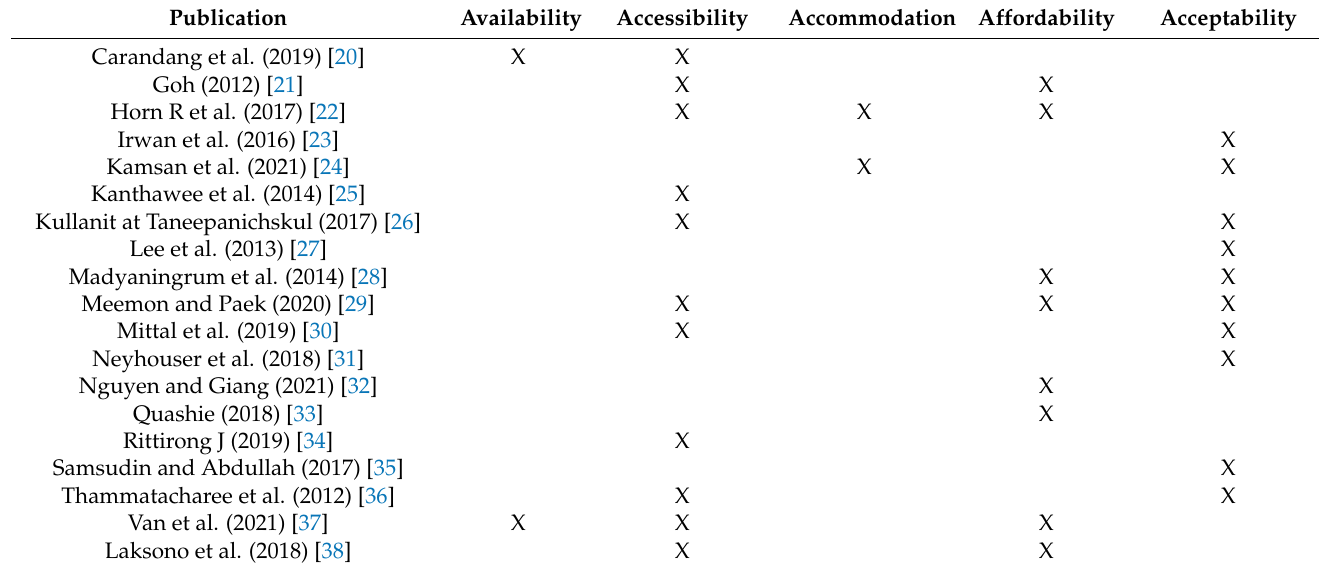
Table 2. Healthcare access issues of included studies according to Penchansky and Thomas’ five dimensions of